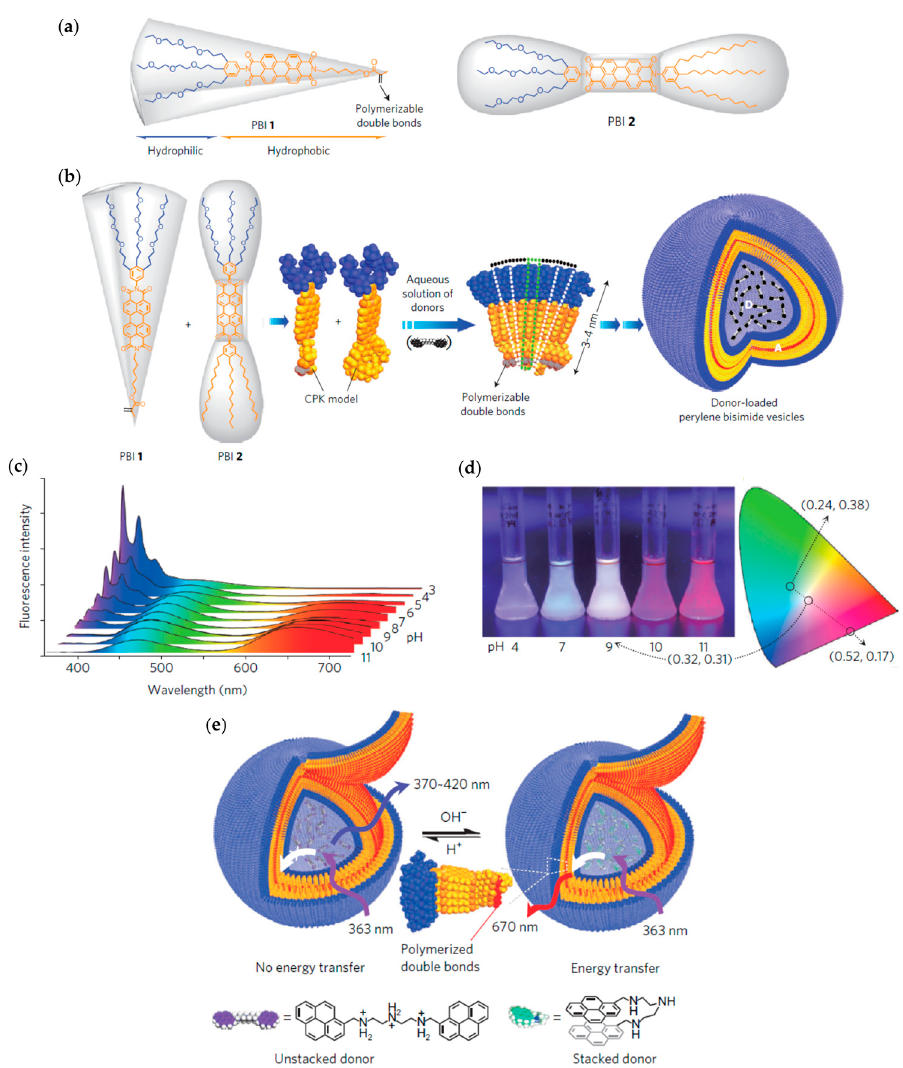
Figure 13. ( a ) Chemical structure of wegde-shaped PBI 1 and dumbbell-shaped PBI 2. ( b ) Schematic illustration based on molecular space-filling (Corey-Pauling-Koltun (CPK)) models for the formation of donor (D)-loaded perylene vesicles in aqueous solution. The water-soluble donor molecules are confined in the aqueous core and the bilayer membrane is composed of perylene bisimide acceptor molecules (A). ( c ) Fluorescence spectra of donor-loaded polymerized vesicles in aqueous solution at pH 3.0–11.0. ( d ) Photograph of donor-loaded polymerized vesicles in aqueous solution at different pH under an ultraviolet lamp (366 nm). ( e ) Schematic illustration of the donor-loaded polymerized vesicles with pH-tunable energy transfer. Copyright Nature, reprinted from Nature Chemistry 2009 [62].